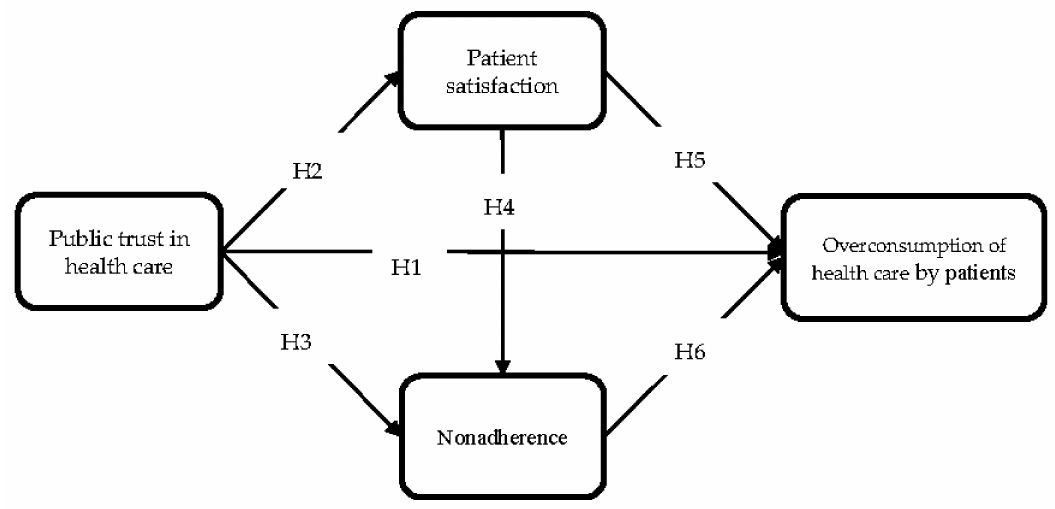
Figure 1. A conceptual research